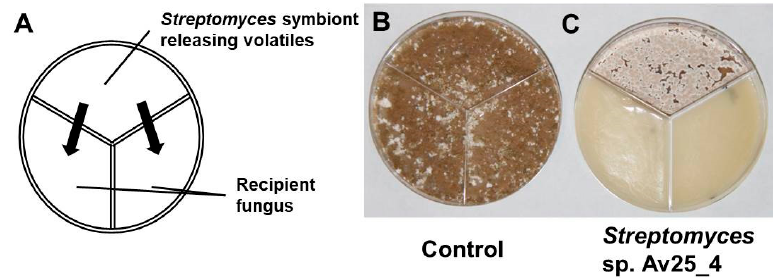
Figure 1. Screening Streptomyces symbionts of leaf-cutting ants for volatile antifungal compounds that inhibit E. weberi . ( A ) Scheme of the experimental set-up in a three compartment Petri dish. ( B ) Growth of E. weberi (control), ( C ) volatiles emitted by Streptomyces sp. Av25_4 completely inhibited the growth of E. weberi